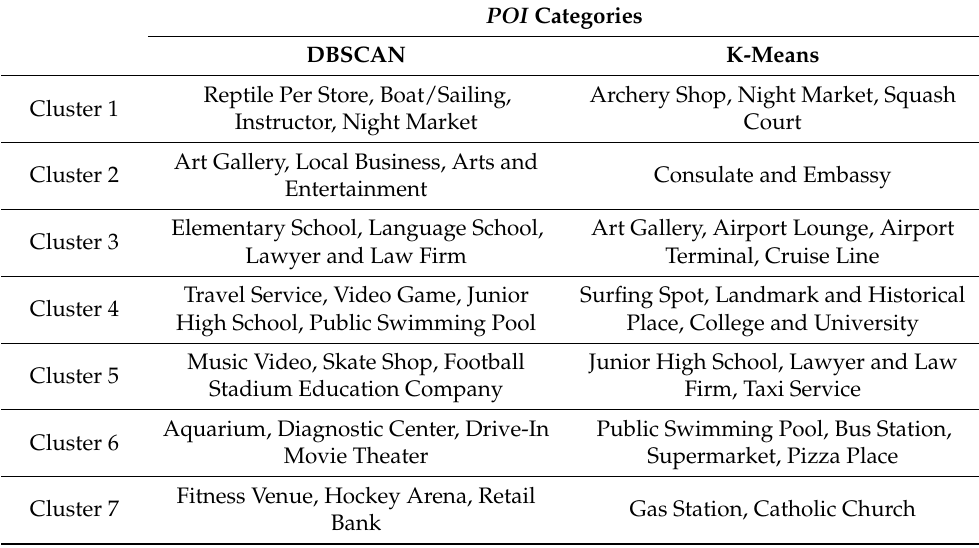
Table 2. Results of